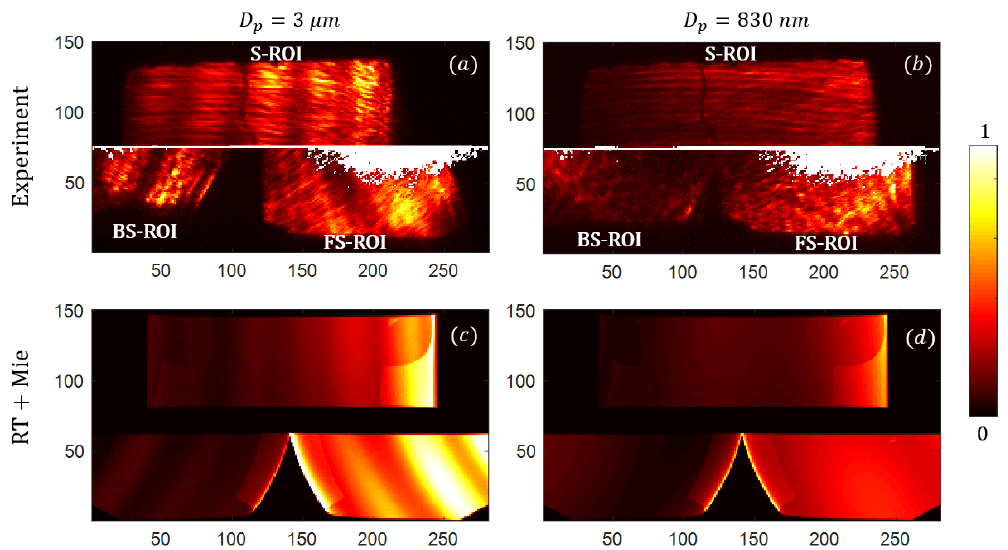
Figure 15. Experimental images of scattering signatures of PSL spheres: ( a ) 3 µ m and ( b ) 830 nm; compared with associated computed signatures: ( c , d )